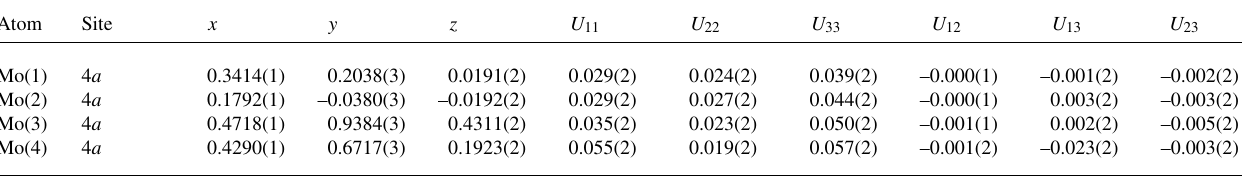
Table 3. Atomic coordinates and displacement parameters (in Å 2 )